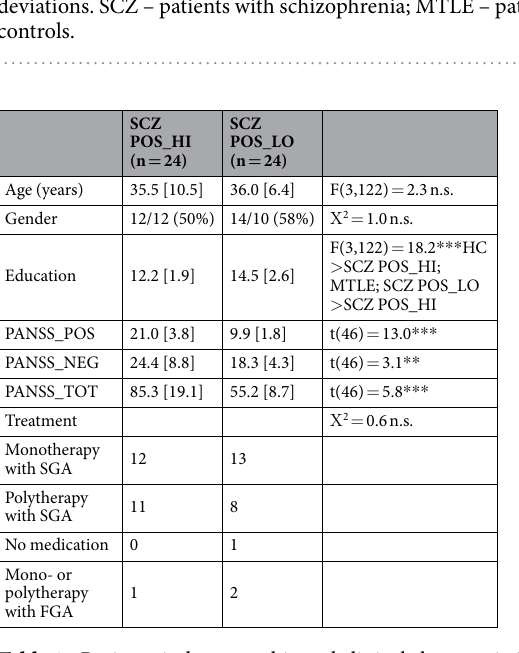
Table 1. Basic sociodemographic and clinical characteristics of the subgroups of patients with schizophrenia. All of the values are given in an M [SD] format with an exception for gender, where the M/F ratio is given. SCZ POS_HI – patients with a high level of positive symptoms; SCZ POS_LO – patients with a low level of positive